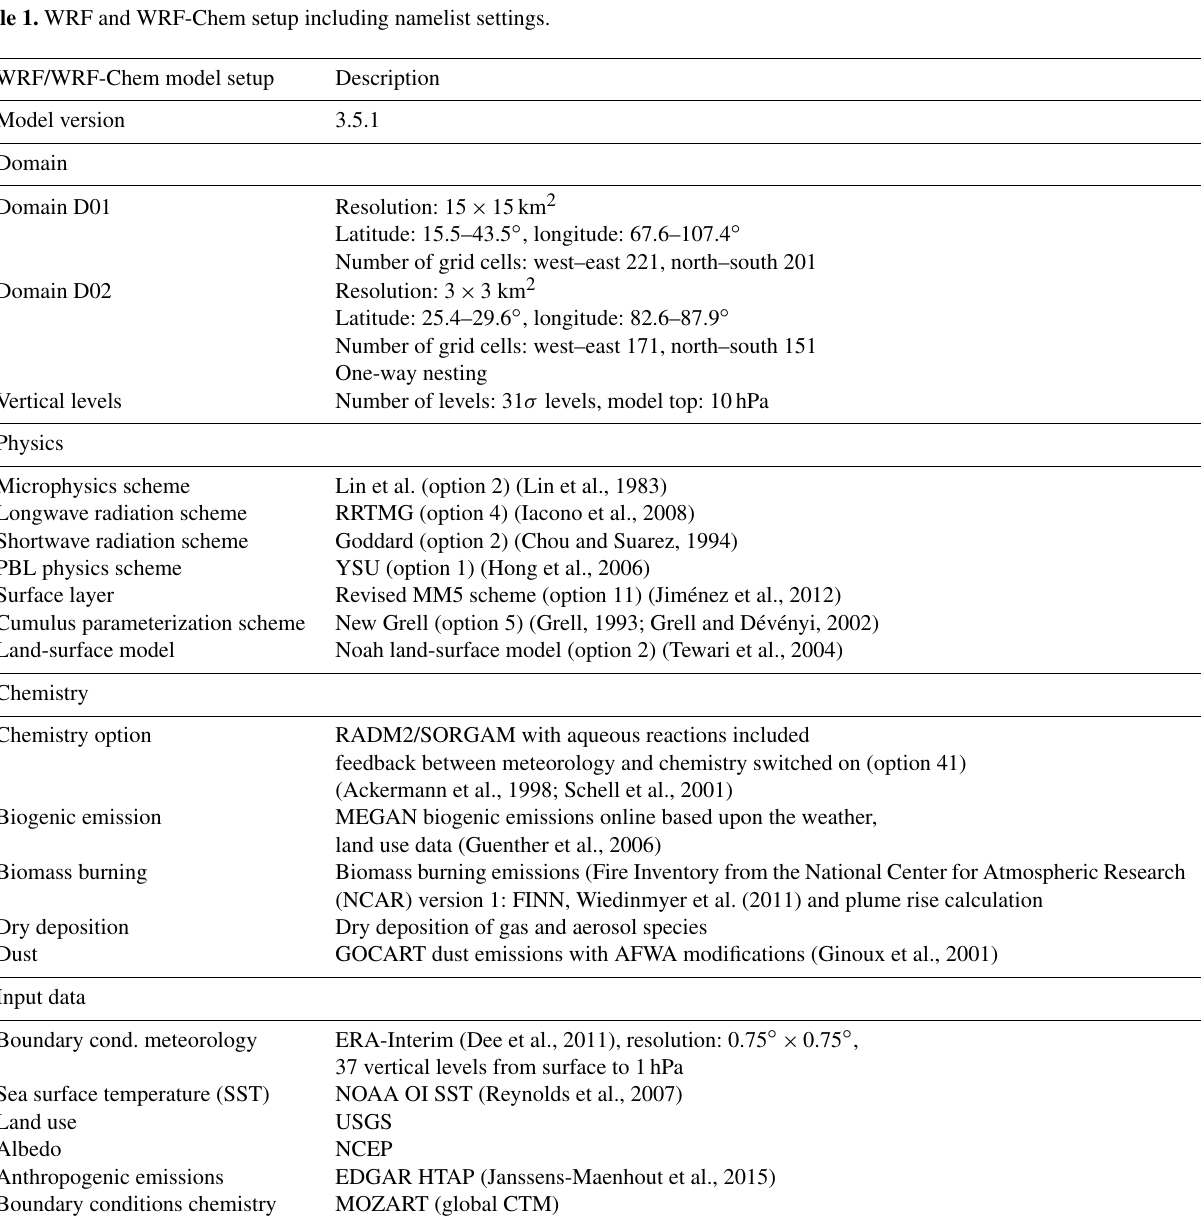
Table 1. WRF and WRF-Chem setup including namelist